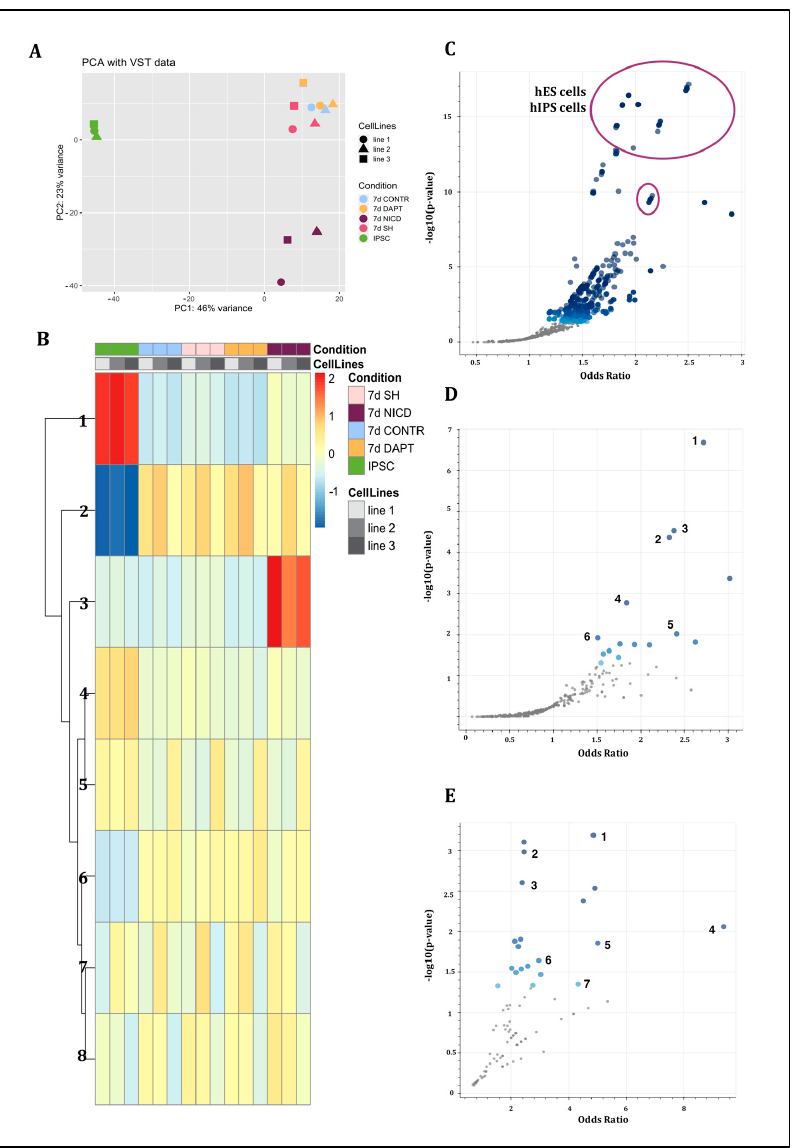
Figure 2. Analysis of RNA sequencing data. ( A ) principal component analysis of non-treated cells (CONTR), cells with RBPJ knockdown (SH), cells with NICD overexpression (NICD), cells treated with DAPT (DAPT) showed similarities of CONTR, SH and DAPT condition, and significant differences in NICD condition. ( B ) Cluster analysis of CONTR, SH, NICD, DAPT conditions showed division into seven clusters. ( C – E ) volcano plots depicting odds ratios and p -values of gene expression levels within selected clusters; ( C ) group of genes from cluster 1 of cluster analysis showed the presence of genes, characteristic for different lines of hIPS cells and hES cells (in circles); ( D ) group of genes from cluster 2 of cluster analysis showed the presence of genes, characteristic for (1) axon guidance (2) Wnt signaling pathway (3) Hippo signaling pathway (4) focal adhesion (5) Hedgehog signaling pathway (6) MAPK signaling pathway; ( E ) group of genes from cluster 3 of cluster analysis showed the presence of genes, characteristic for (1) Notch signaling pathway (2) Integrin signaling pathway (3) angiogenesis (4) pyruvate metabolism (5) opioid proopiomelanocortin pathway (6) ubiqitine proteasome pathway (7) GABA-B receptor II